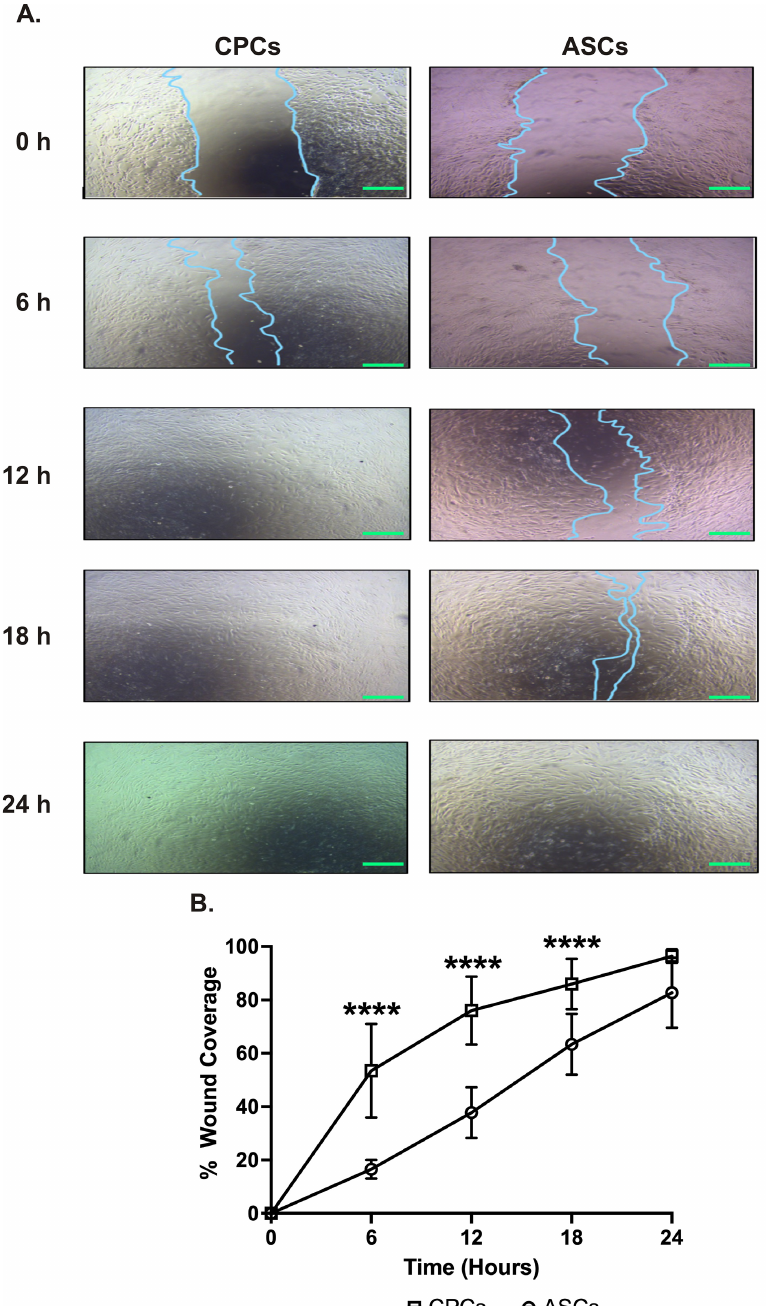
Figure 2. CPC migrates faster. ( A ) Representative images showing the migration of CPCs and ASCs to cover the wound. Images are taken at different time points at 40 × magnification. Scale bars, 500 µ m. ( B ) Line graph showing the percentage wound coverage over the 24 h experimental period. Data are represented as percentage of wound coverage and are mean ± SEM; n = 8 in each group; **** p <